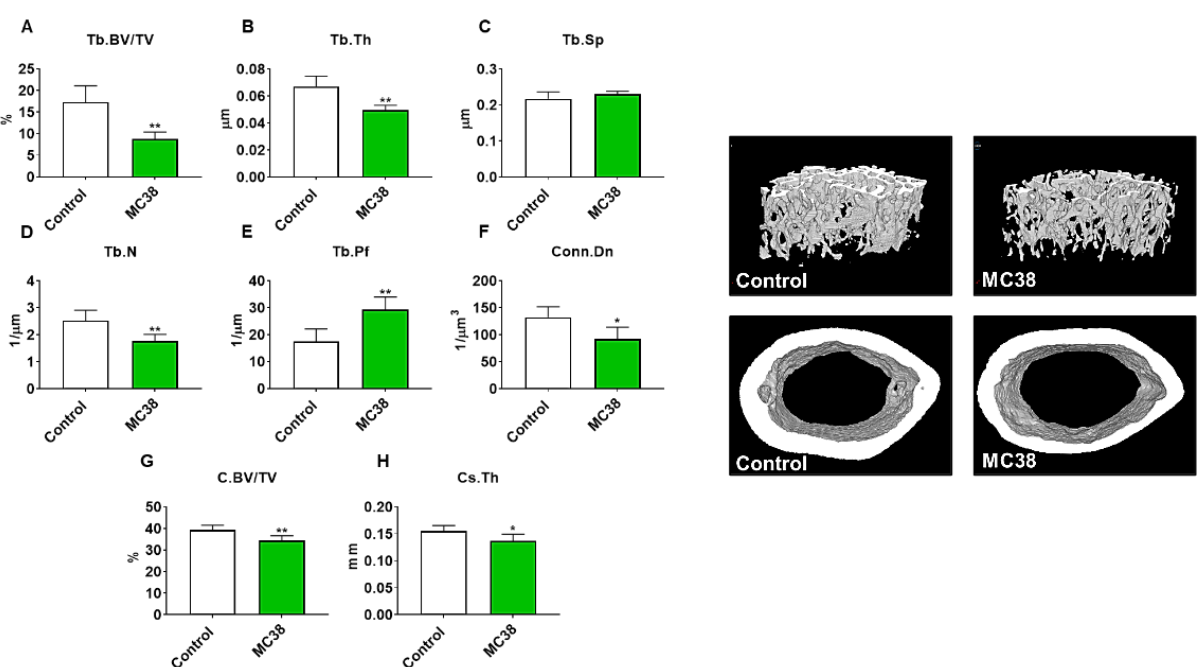
Figure 3. Growth of subcutaneous MC38 tumors causes loss of cancellous and cortical bone. Representative three-dimensional analysis of microcomputed tomography ( µ CT) scanned images and quantification of trabecular bone volume fraction (Tb.BV/TV) ( A ), trabecular thickness (Tb.Th) ( B ), trabecular separation (Tb.Sp) ( C ), trabecular number (Tb.N) ( D ), trabecular pattern factor (Tb.Pf) ( E ), trabecular connectivity density (Conn.Dn) ( F ), cortical BV/TV ( G ) and cortical cross-sectional thickness (Cs.Th) ( H ) of femurs from C57BL/6 male mice (8 weeks) subcutaneously injected with MC38 tumor cells (1.0 × 10 6 cells/mouse in sterile PBS: MC38) or an equal volume of vehicle (control) ( n = 5). Data presented as mean ± s.d. * p < 0.05, ** p < 0.01 vs. control.